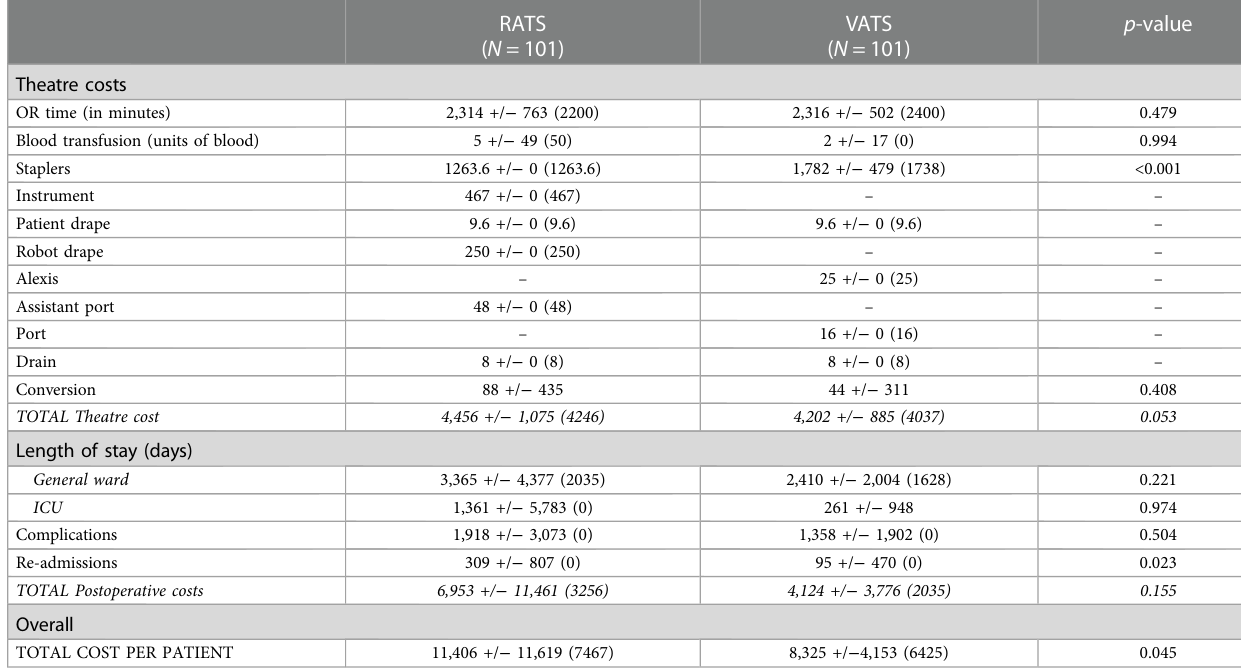
TABLE 6 Cost comparison of RATS and VATS lung